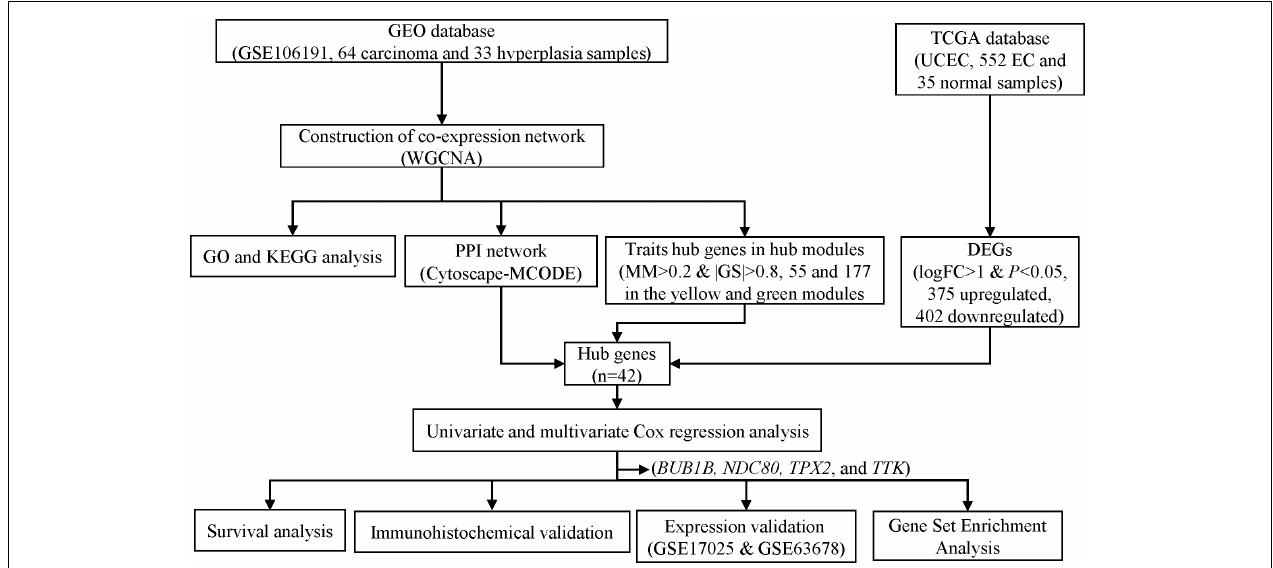
FIGURE 1 | Flowchart of screening hub genes and validation. GEO, Gene Expression Omnibus. TCGA, the Cancer Genome Atlas. GO, Gene ontology. KEGG, Kyoto Encyclopedia of Genes and Genomes. UCEC, uterine corpus endometrial carcinoma. PPI, protein-protein interaction. MCODE, Molecular Complex Detection. MM, module membership. GS, gene significance. DEG, differentially expressed genes.